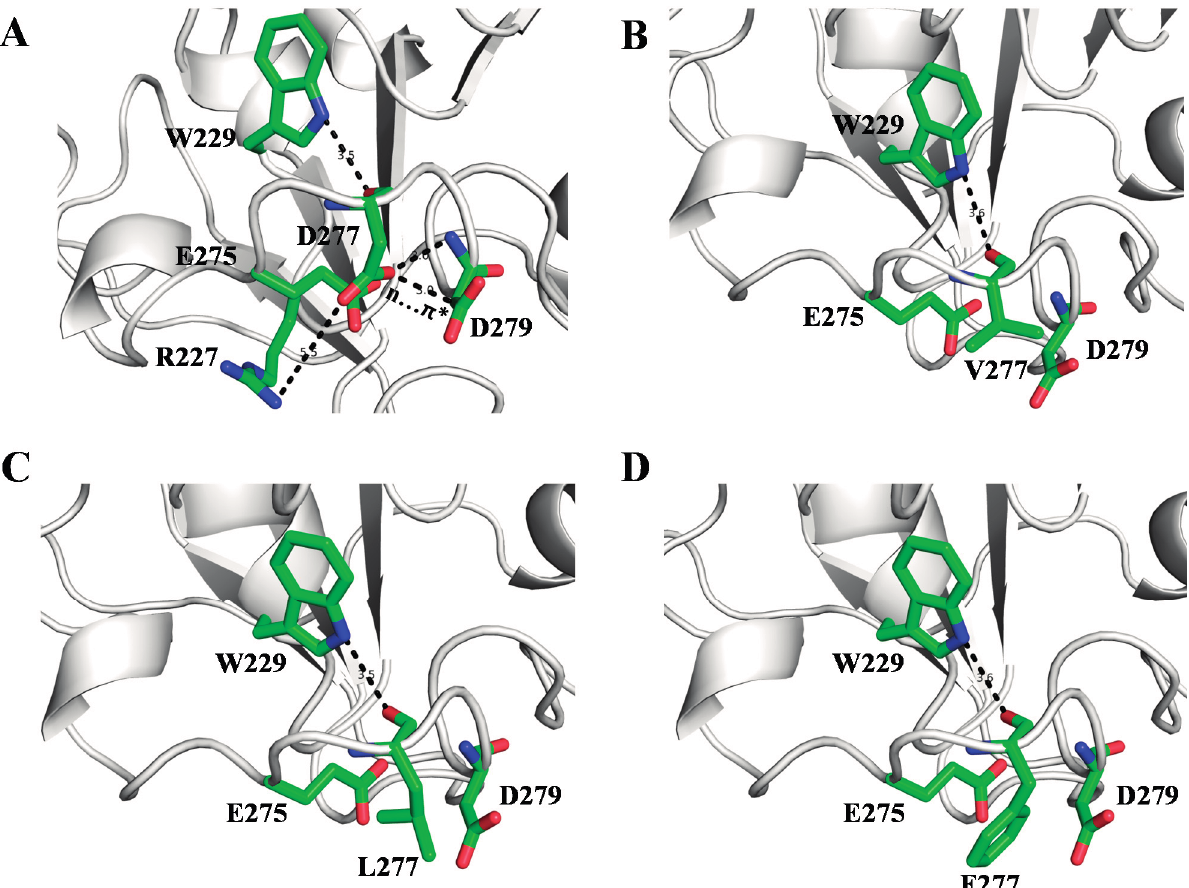
Figure 5. Structure models of N277D ( A ); N277V ( B ); N277L ( C ) and N277F ( D ) mutants. Carbon, oxygen and nitrogen atoms are colored as green, red and blue,